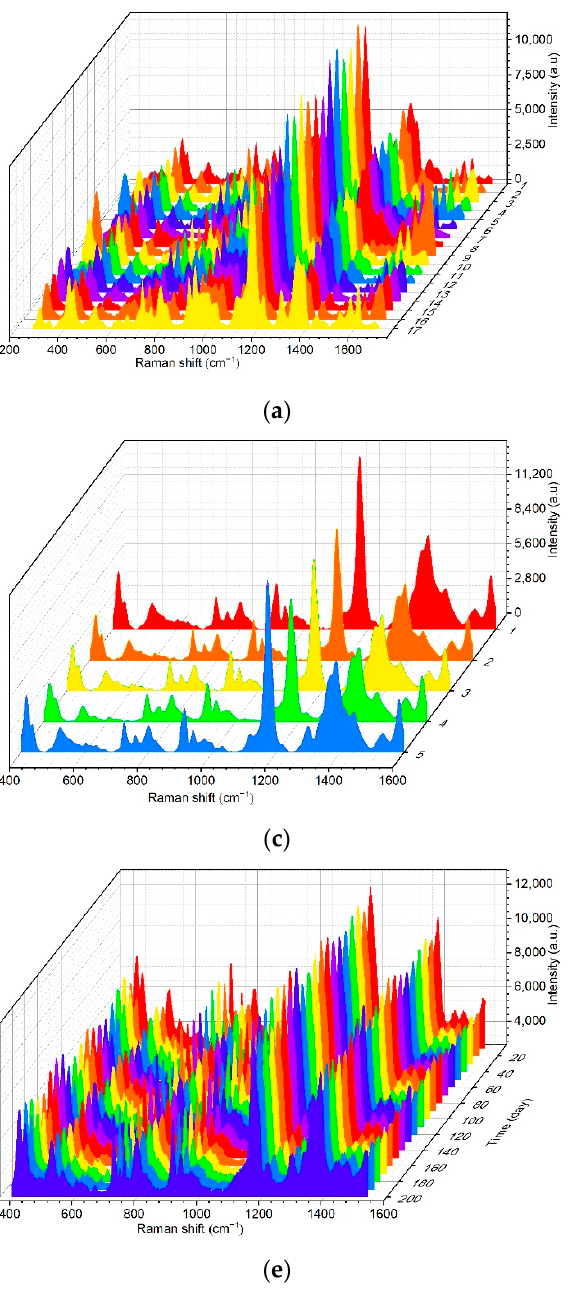
Figure 5. Uniformity, reproducibility and stability of the Au-TPP substrate. ( a , b ) Uniformity tests: ( a ) randomly select 17 different positions on the Au-TPP substrate to record the SERS signal of CV, ( b ) the RSD value of the corresponding signal calculated from the characteristic peak of 1171 cm − 1 ; ( c , d ) reproducibility tests: ( c ) SERS spectra of CV on 5 batches of the Au-TPP substrate, ( d ) the RSD value of the corresponding signal calculated from the characteristic peak of 1171 cm − 1 ; ( e , f ) stability tests: ( e ) SERS signal detection of CV using Au-TPP substrates stored for approximately 200 days, ( f ) peak intensities of 1171 cm − 1 and 722 cm − 1 recorded during different storage periods.